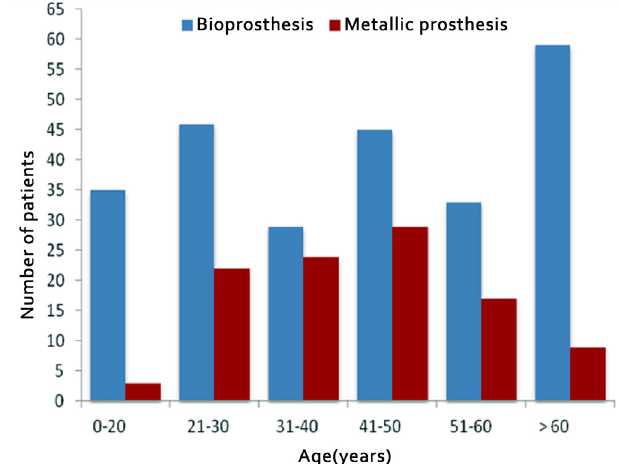
Fig. 1 - Distribution of valve prostheses by age.